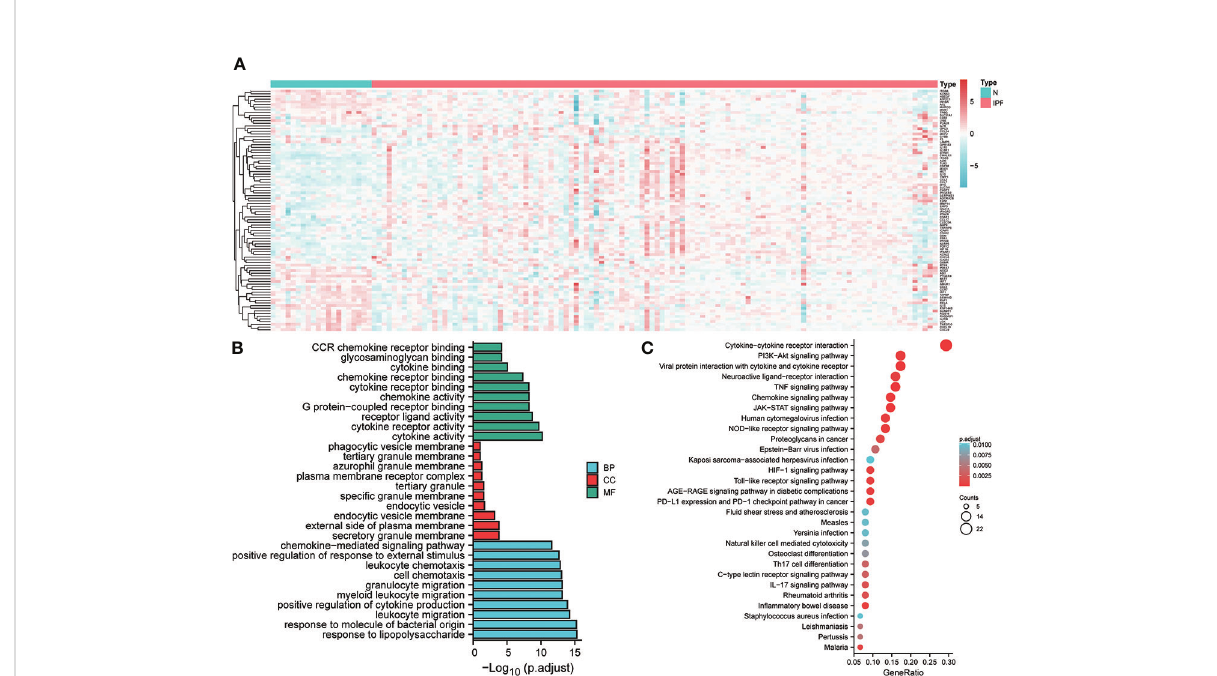
FIGURE 1 Expression and enrichment analysis of in fl ammation-linked genes in IPF. (A) Heat map of the expression of genes linked with in fl ammation in the discovery set. (B) GO enrichment analysis of DEGs. (C) KEGG analysis of